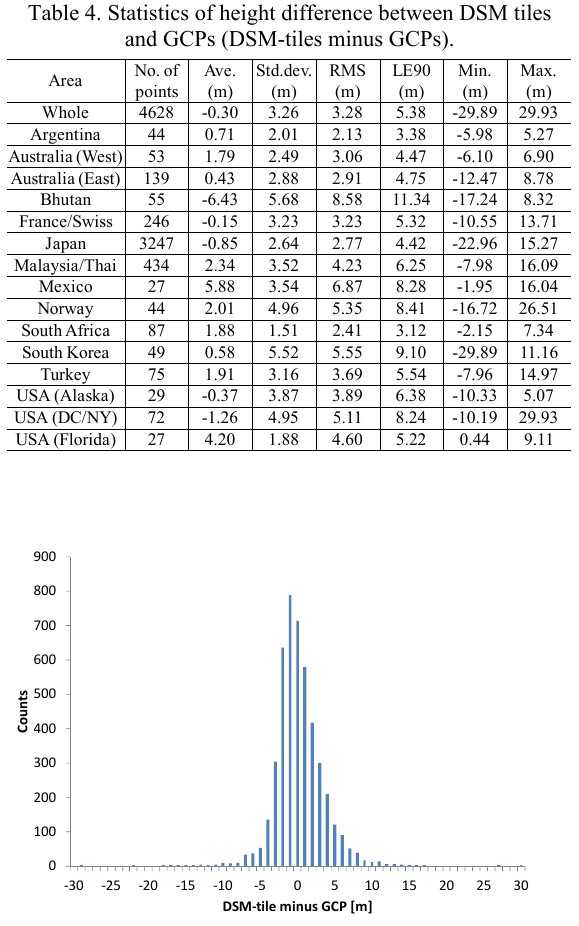
Figure 5. Histogram of the height differences from 4,628